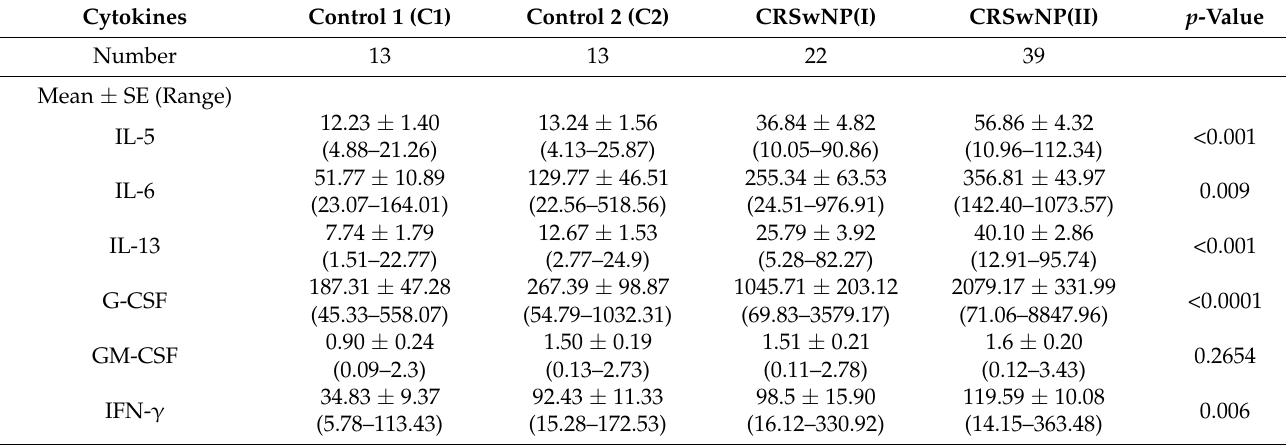
trol 1 from inferior turbinate mucosa. Control 2 from middle turbinate mucosa. p < 0.05 were considered statistically sig ‐ nificant differences.